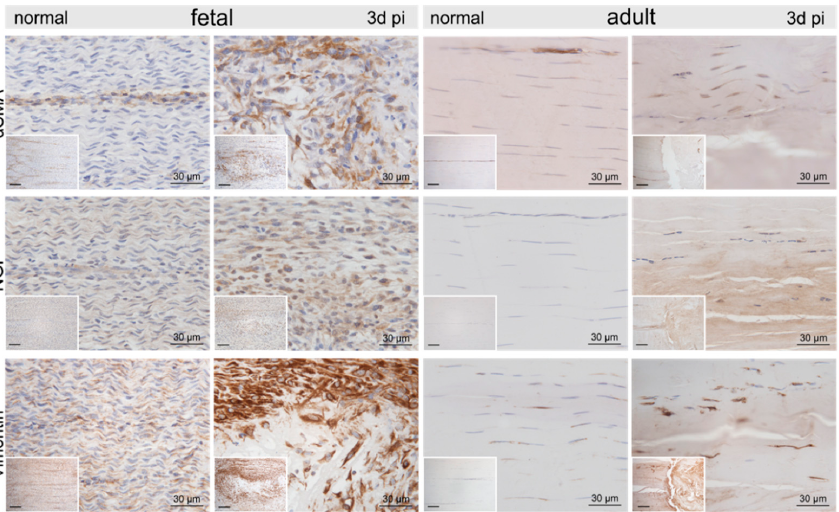
Figure 4. Representative micrographs of normal control and injured fetal and adult tendons three days post ‐ injury (pi). Compared to the control tendons, we found an up ‐ regulation of α‐ smooth muscle actin ( α SMA), nerve growth factor (NGF), and vimentin within and around the lesion site in both age groups. Inserts show an overview at 10× magnification, scale bar = 100 μ m.